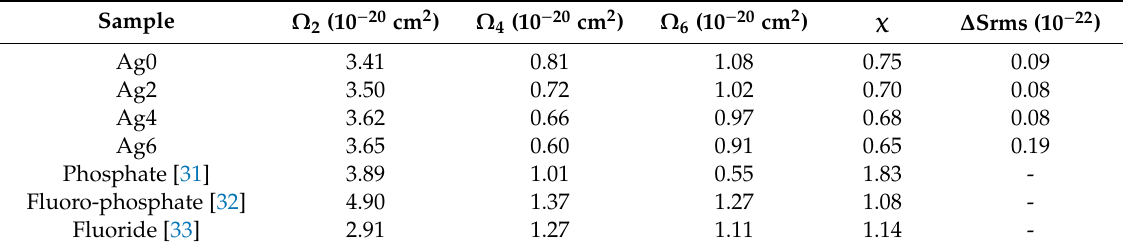
Table 3. Judd-Ofelt parameters Ω i (i = 2, 4, and 6), spectroscopic quality factor ( χ ), and root-mean-square deviation ( ∆ S rms ) of Ag / Er 3 + -doped glasses.